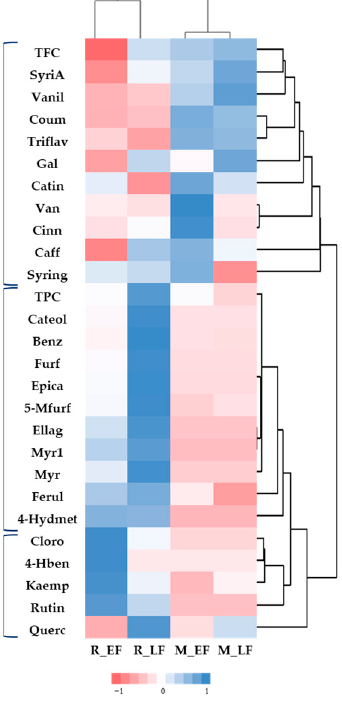
Figure 1. Heat maps plotting clusters of contents of phenol compounds, TPC and TFC analysed by HPLC of the A. retinodes and A. mearnsii flowers with different flowering stages. TFC—Total phe-